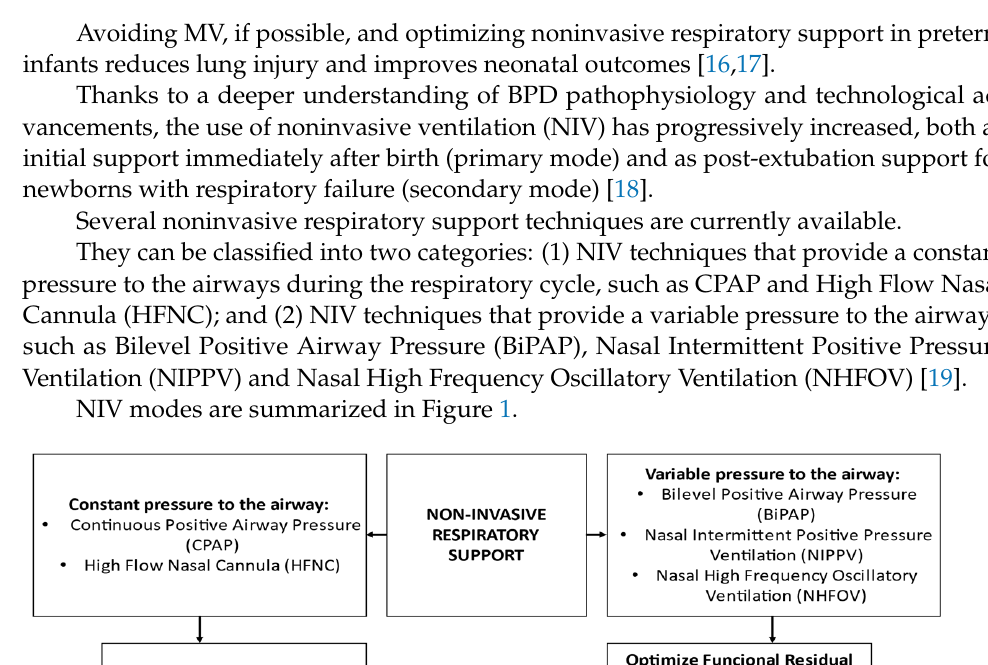
Figure 1. Different non-invasive respiratory support techniques.